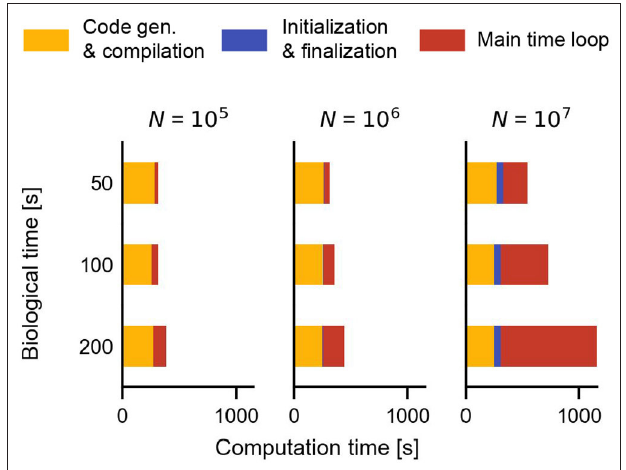
FIGURE 8 | Additional time required during a simulation with Brian2CUDA for the STDP benchmark with homogeneous delays ( Figure 5D ). Code generation and compilation times (yellow) are independent of network size and biological time. Network initialization and finalization (blue) depend on network size but not on biological time. Simulation of the main time loop (red) scales with both, biological time (linearly) and with network size. Compilation was performed in parallel on 16 CPU